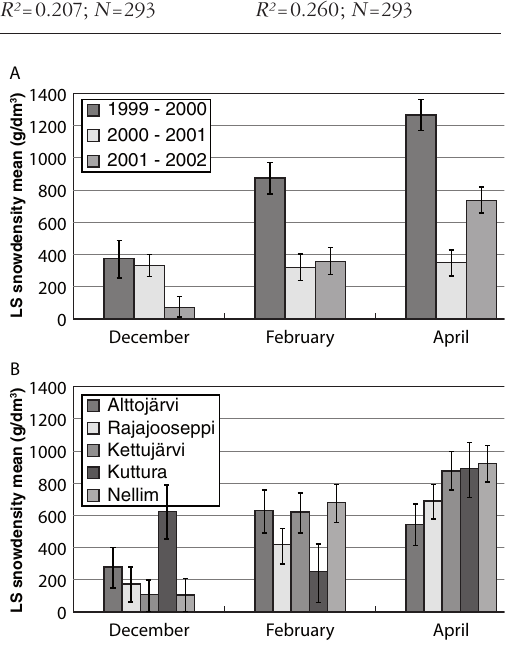
Fig. 7. Snow hardness (g/cm 2 , LS mean ± SE) a) in differ- ent months and b) in different measurement areas during winters 1999 - 2002 in the Ivalo reindeer herding